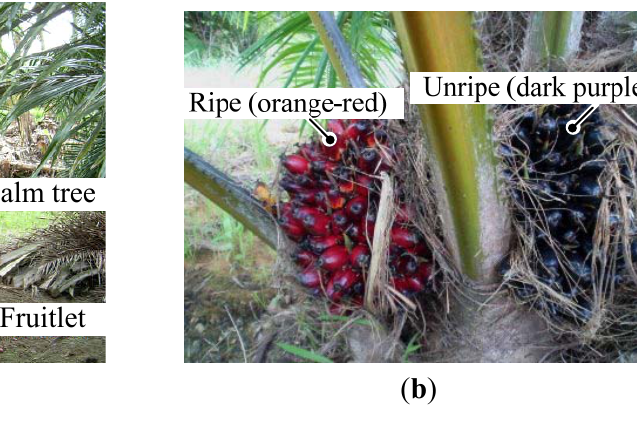
Figure 1. Samples of oil palm fruitlet ( a ) Oil palm fruit tree ( b ) Two category of